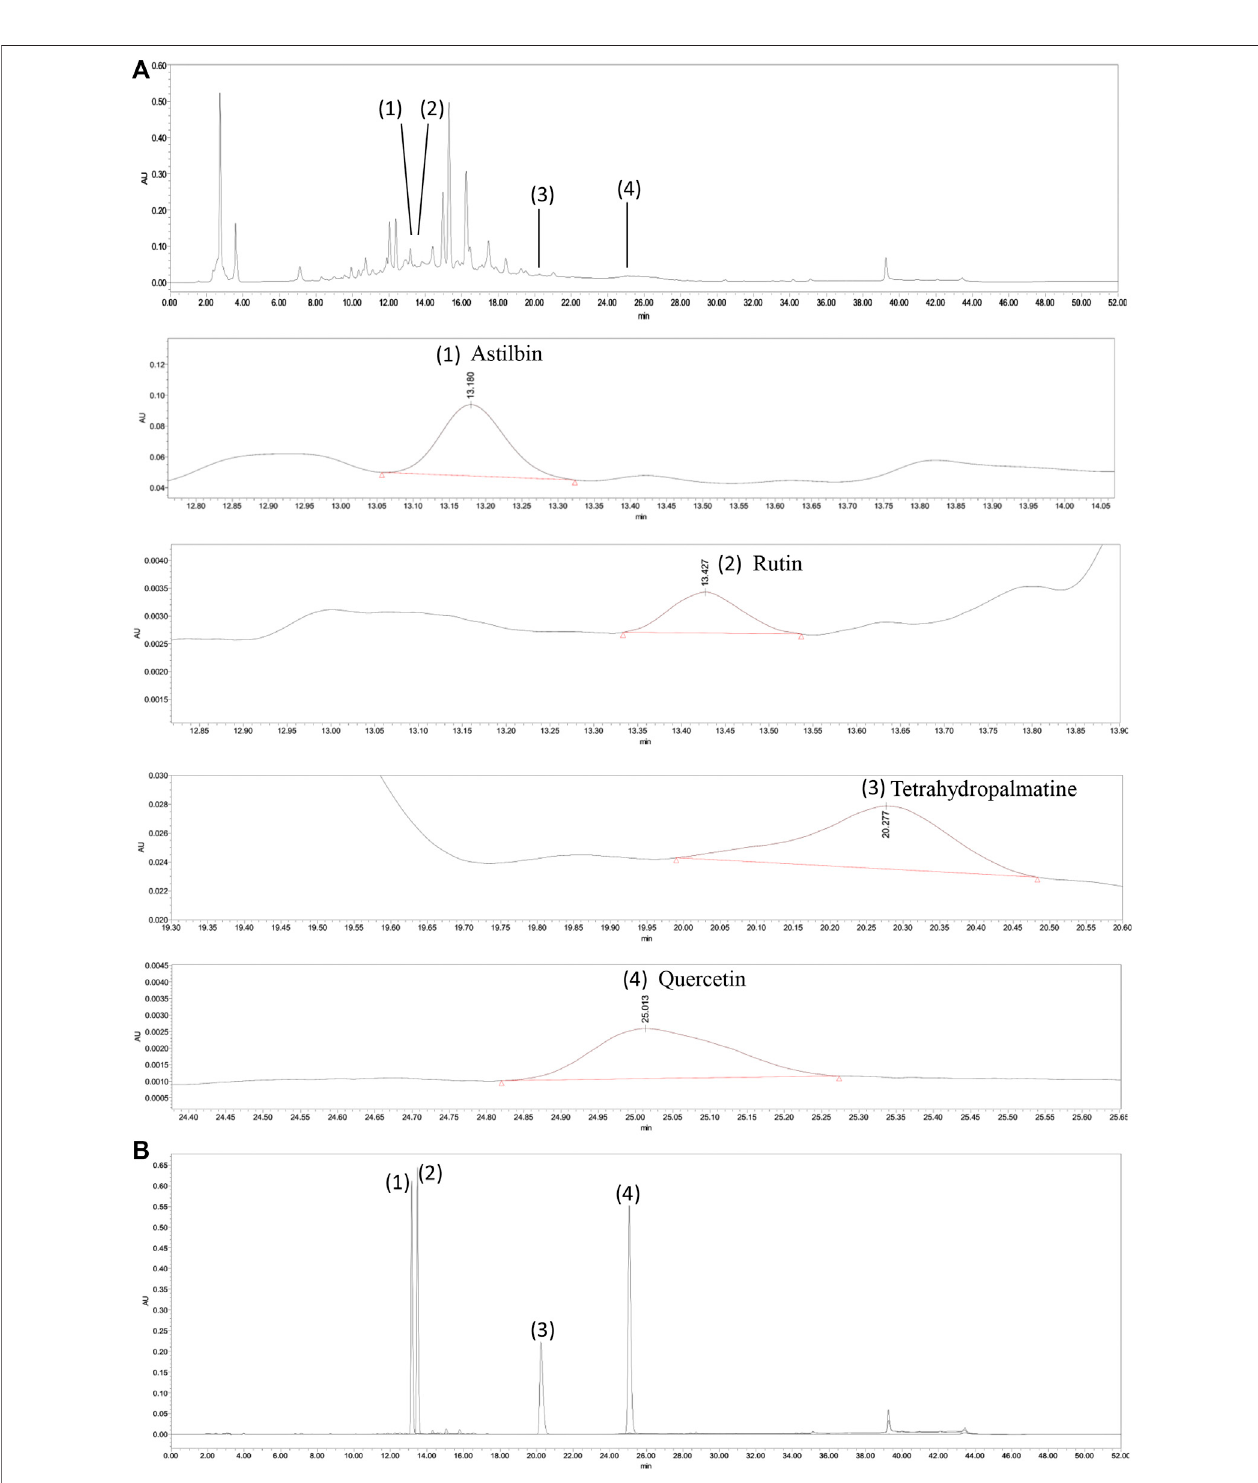
FIGURE 1 | HPLC analysis of Qu-zhuo-tong-bi decoction (QZTBD). QZTBD (A) and standard substance (B) . Identi fi cation of main compounds in QZTBD as follows: Astilbin (1), Rutin (2), Tetrahydropalmatine (3), and Quercetin (4).